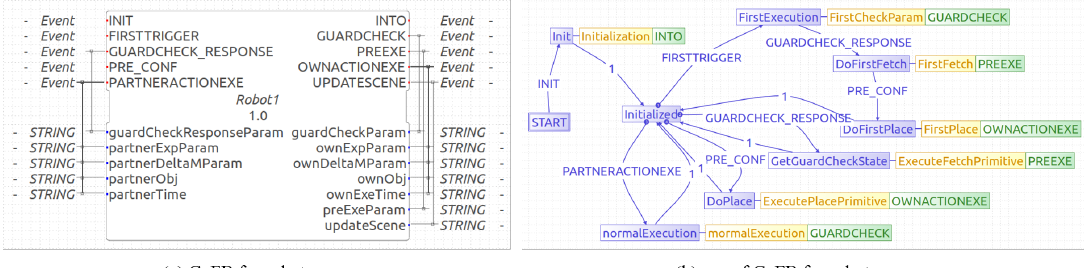
Figure 4. The GeFB and ecc for